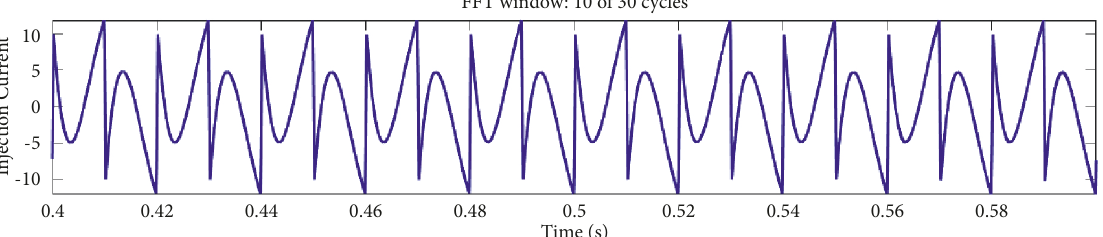
Figure 31: Waveform of the output current of HAPF with the implementation of fuzzy logic